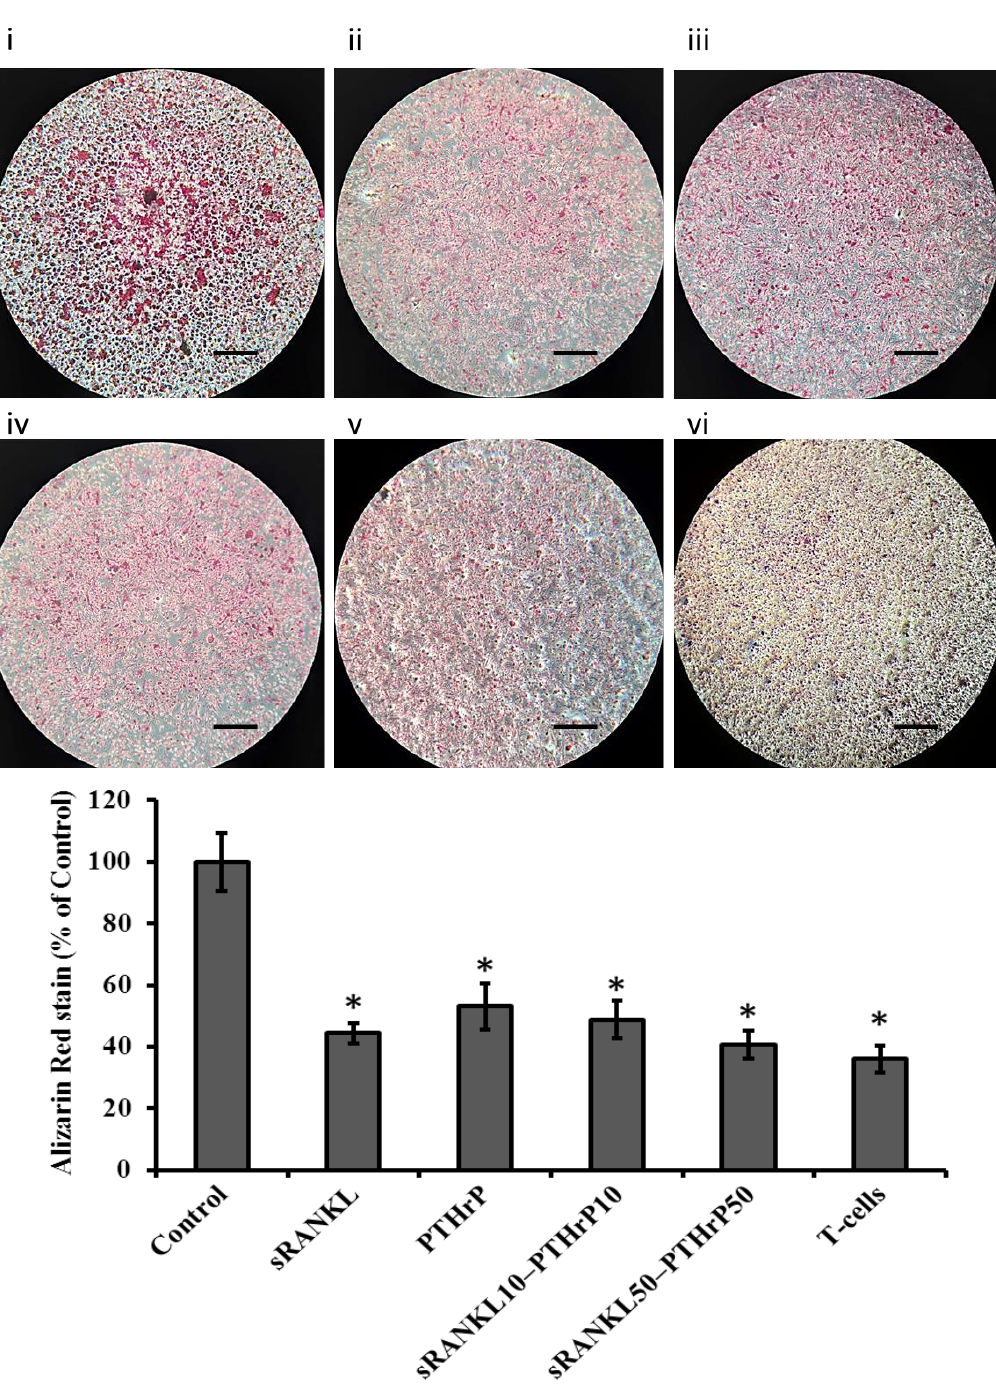
Figure 8. The level of Alizarin red staining of di ff erentiated MSCs by sRANKL and PTHrP. ( i ) control, ( ii ) sRANKL, ( iii ) PTHrP10, ( iv ) sRANKL10–PTH10, ( v ) sRANKL50–PTHrP50, ( vi ) T-cells-MSCs, scale bars: 0.1 cm. * p < 0.05 vs. control.